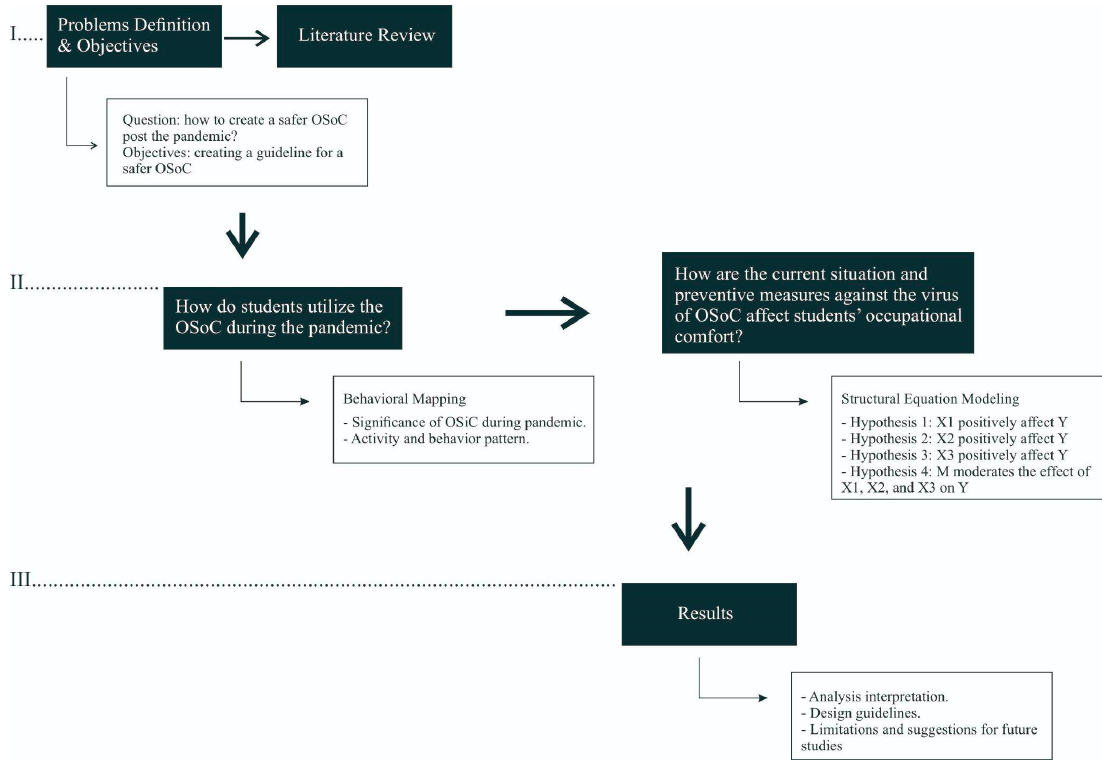
Figure 1. The research